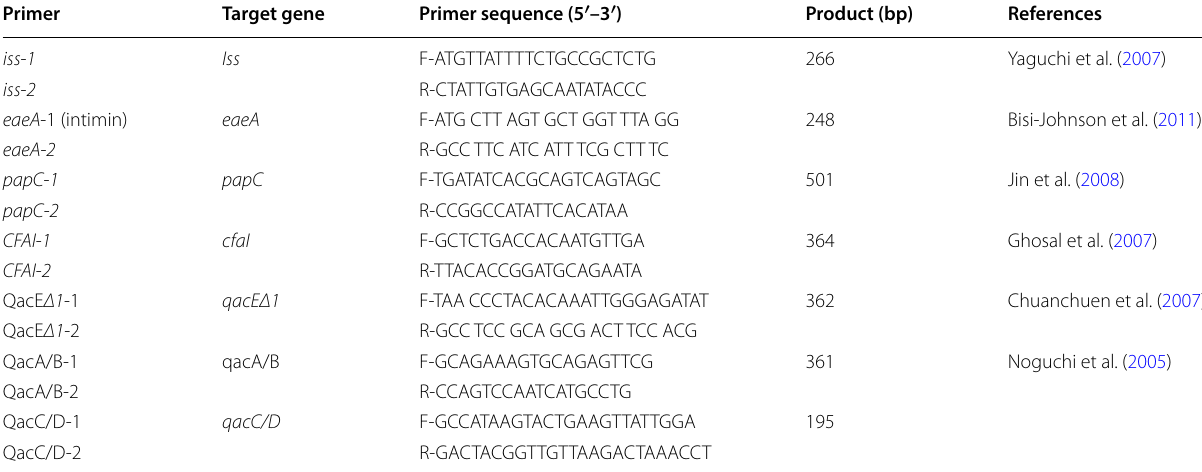
Table 1 Oligonucleotide primers sequences encoding for amplification of virulence genes and QACs resistance genes Primer Target